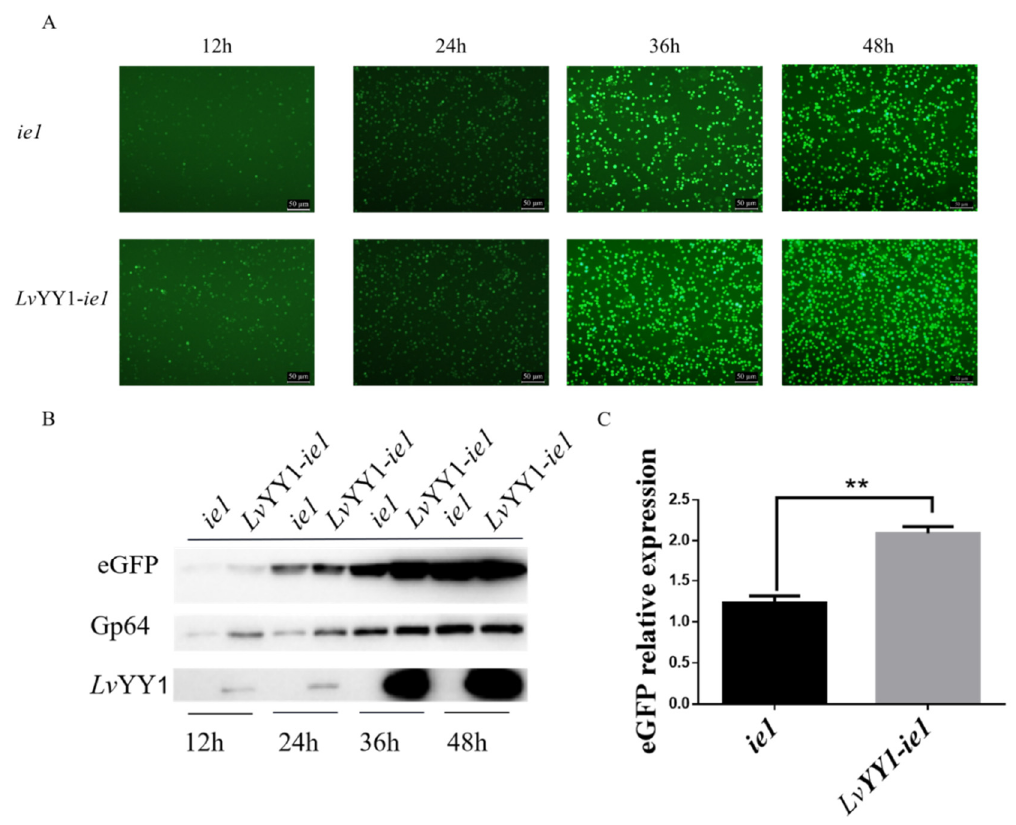
Figure 4. Comparative expression levels of eGFP based on interaction between WSSV ie1 and Lv YY1. ( A ) Sf-9 cells were infected with the same titer of recombinant baculovirus. Fluorescence microscopy showed expression of eGFP under WSSV ie1 promoter and Lv YY1 at di ff erent time points post-infection (magnification, 100 × ). ( B ) Total proteins were extracted at di ff erent time points post-infection, and subjected to Western blot analysis for eGFP and Lv YY1 expression. GP64 served as internal reference (Supplemental Materials). ( C ) The ratios of band intensity of eGFP to Gp64. Data represented as the mean ± SD of three independent experiments. ** p < 0.01, unpaired Student’s t -test.